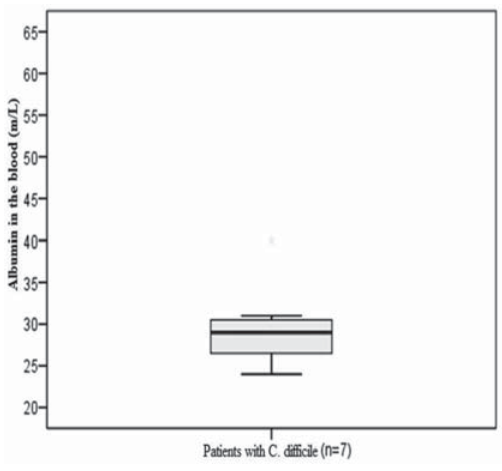
FIGURE 4. Albumin in the blood at patients with C.diffi cile (Mean=29.0 g/L; IQR=26.0 to 31.0) compared to referent val- ues (53.0-64.0 g/L) (Z=-2.281;